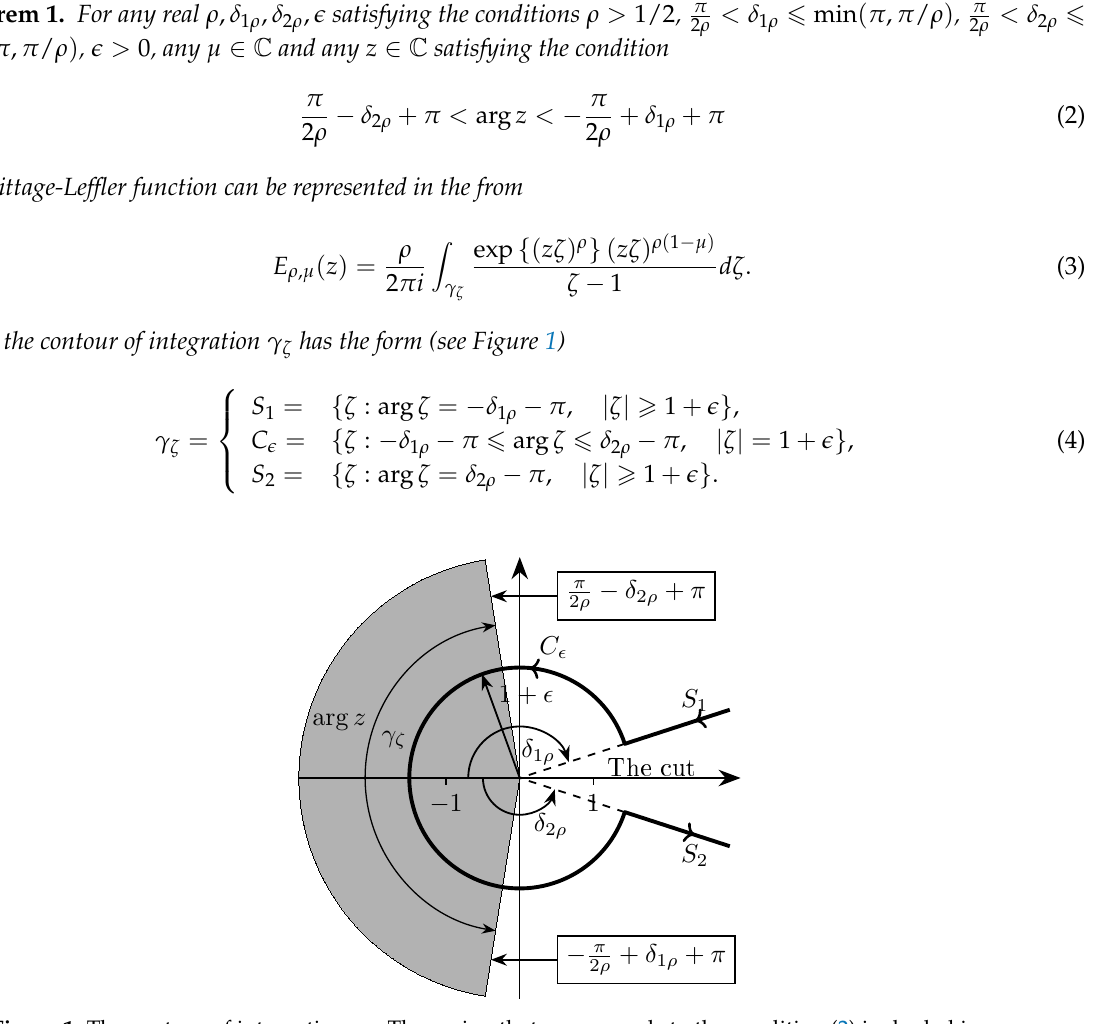
Figure 1. The contour of integration γ ζ . The region that corresponds to the condition (2) is shaded in grey. The proof of this theorem can be found in the work